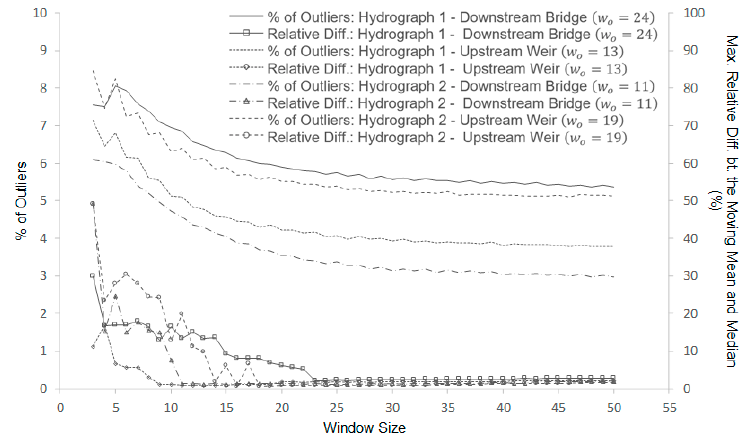
Figure 5. Outlier detection rate and maximum relative difference between the moving mean and median according to window size.